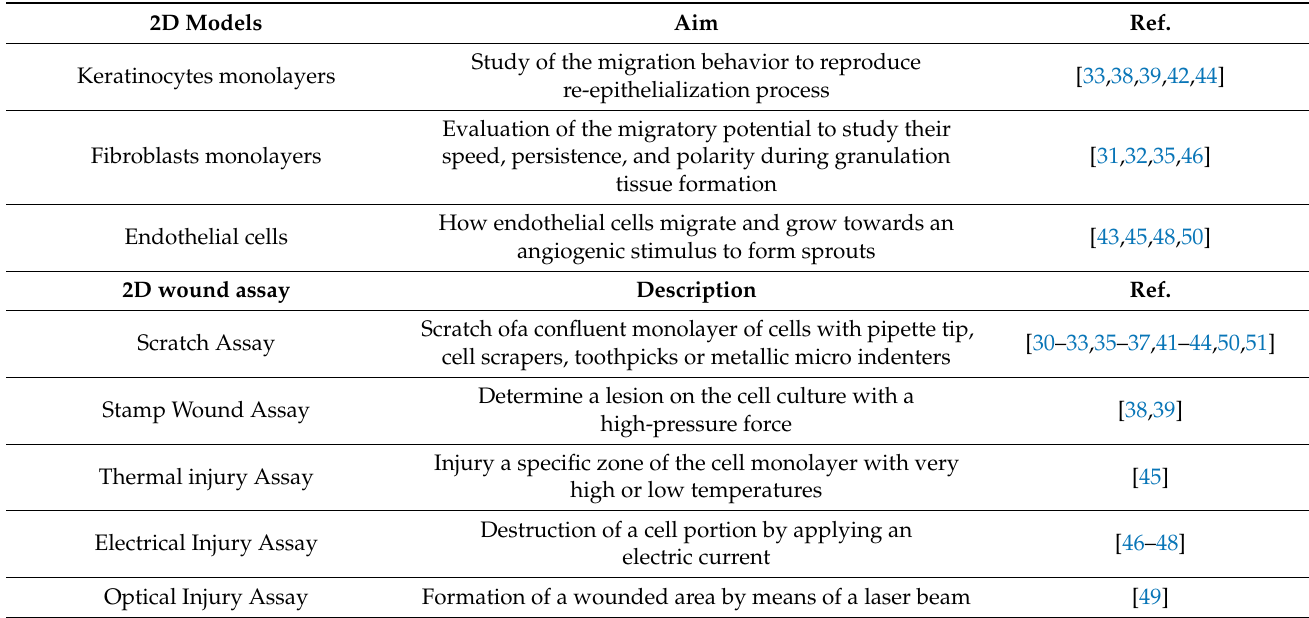
Table 2. Common 2D models used for bidimensional wound healing